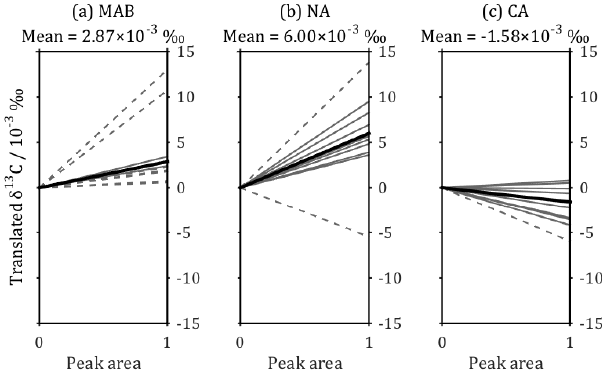
Figure 2. Peak area vs. δ 13 C relationships used for the peak area correction of the calibration standards (a) MAB, (b) NA and (c) CA (Table 2). The grey lines are the linear least-squares best fit for each analysis batch but are vertically translated to have a y intercept of 0, so that the y value of the line at a peak area of 1 is equal to the gradient. The thick black line is the mean gradient for each standard; the dashed grey lines indicate batches excluded from calculation of the mean (see Sect. 4.1.3 for exclusion